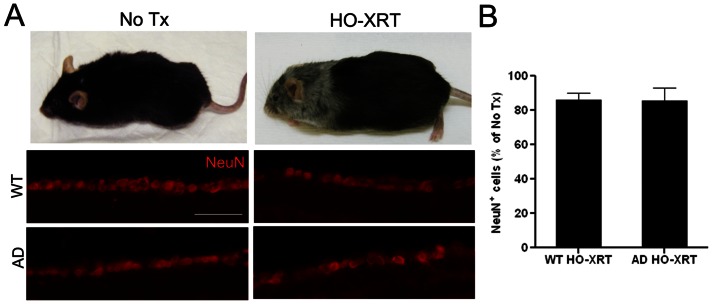
RGCL neuroprotection is not due to effects of high dose cranial irradiation alone.
A: Representative photographs of control mice (no Tx) and mice that received head only irradiation (HO-XRT) demonstrate effects of irradiation on coat color and confirm radiation exposure in HO-XRT mice (top). Representative photomicrographs of NeuN+ neurons (red) in RGCL stained with NeuN antibody and visualized with Cy3-conjugated secondary antibody show a mild reduction in neuron density 8 months after HO-XRT (bottom). Scale bar  = 50 μm. B: Quantification of neuron density depicted as a percent of age-matched, non-irradiated wt controls demonstrates there is a mild reduction in RGCL neurons as a result of high dose irradiation without BMT in wt and APPswe-PS1ΔE9 mice, thus eliminating the possibility that high dose cranial irradiation underlies the neuroprotective effects of BMT.